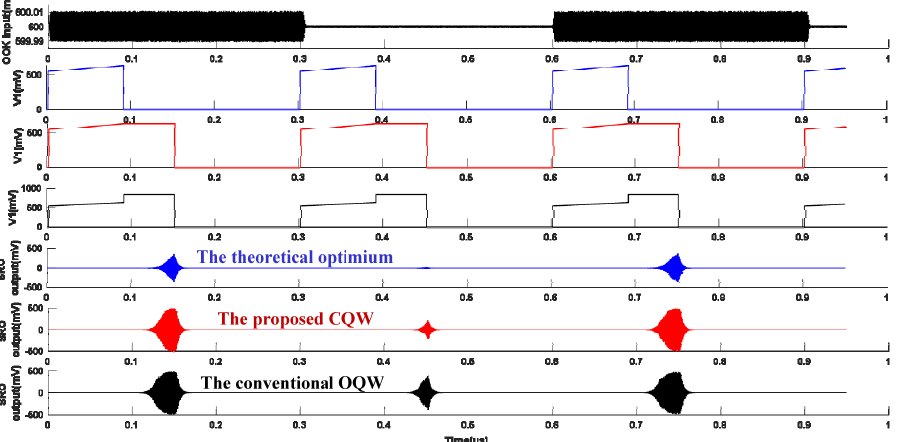
Figure 17. The simulation results illustrating noise analysis comparison between the proposed CQW technique and the conventional OQW technique. From top to bottom: the input OOK signal, the proposed CQW quenching voltage V 1b , the proposed CQP quenching voltage V 1a , the conventional OQW quenching voltage, and the SRO output signals corresponding with different quenching waves.